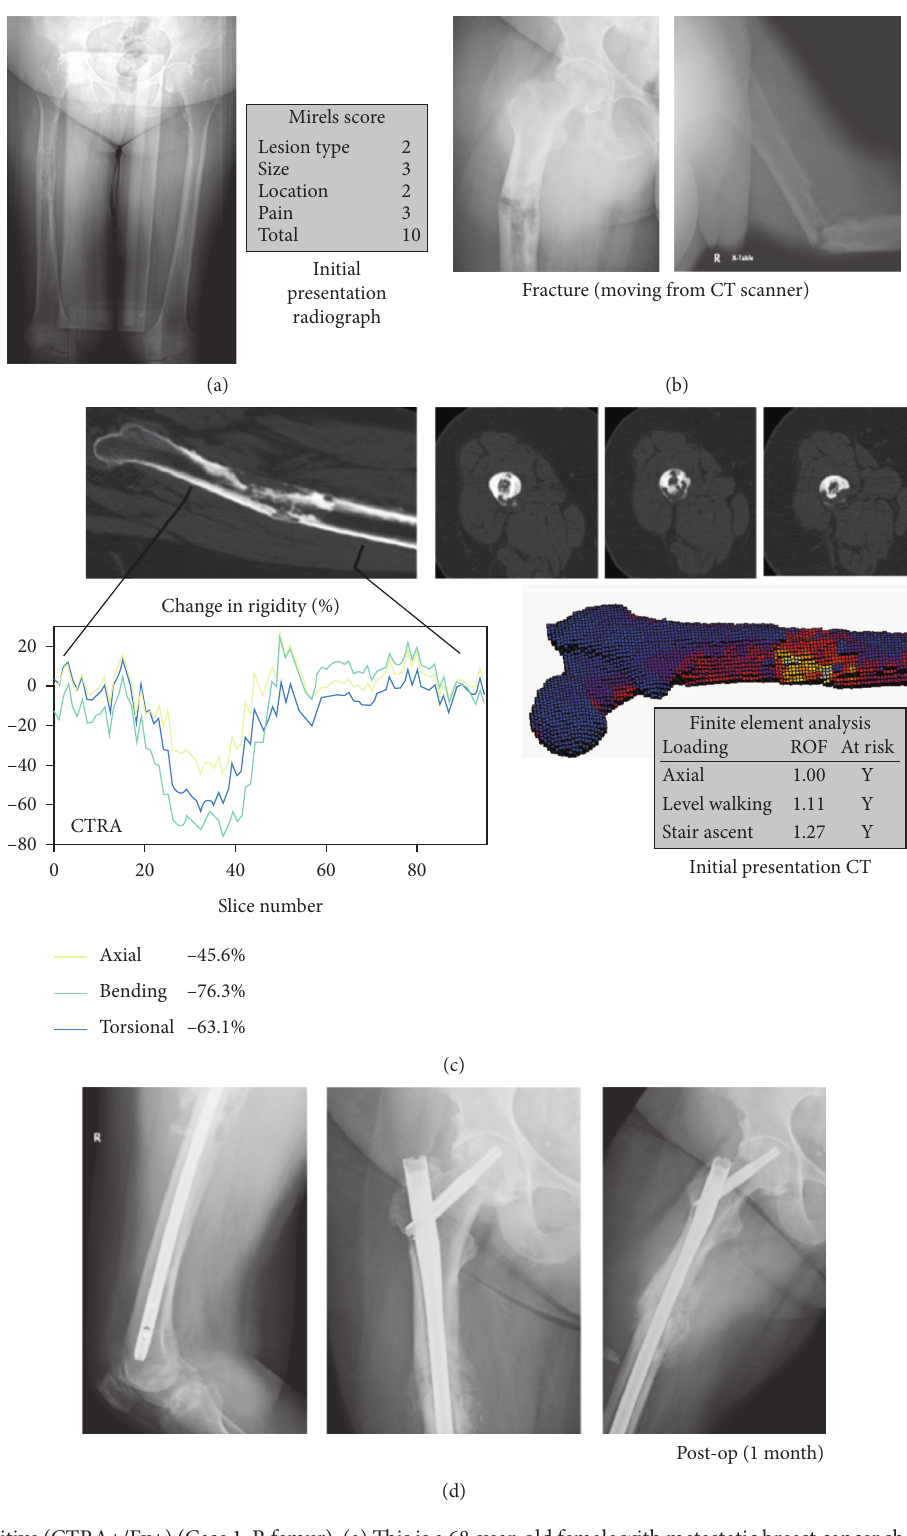
Figure 2: True positive (CTRA+/Fx+) (Case 1, R femur). (a) This is a 68-year-old female with metastatic breast cancer showing an osteolytic lesion in the right femoral diaphysis on X-ray imaging, (b) who, while moving from the CTscanner, fractured her right femur. (c) CTRA and FEA analysis both predicted fracture in this patient. (d) She was admitted and taken for surgical fixation of the right